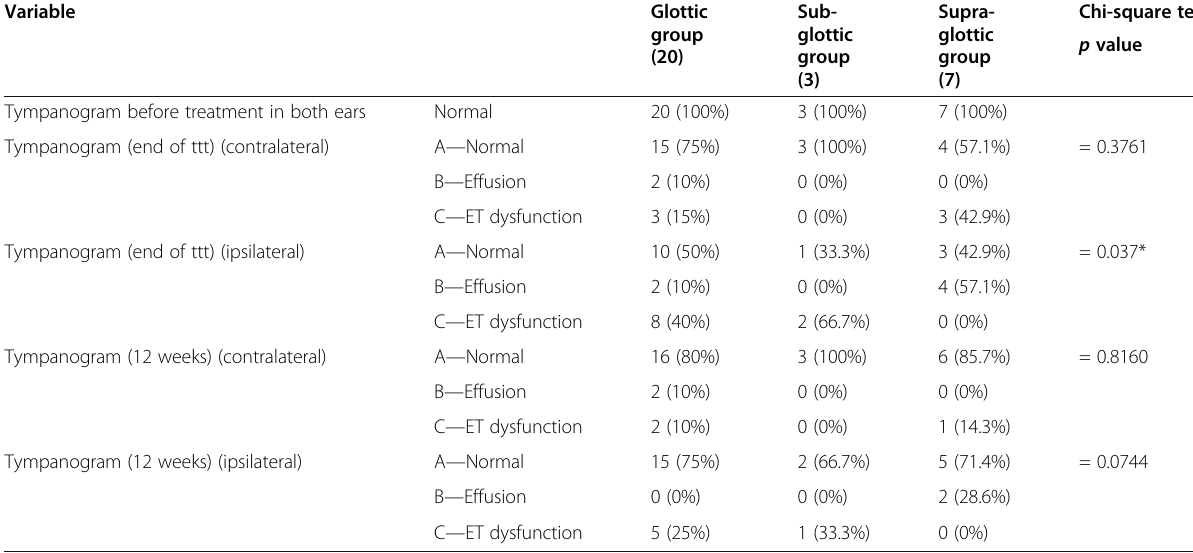
Table 2 Comparison between the 3 groups as regards follow-up tympanogram data using chi-square test Variable